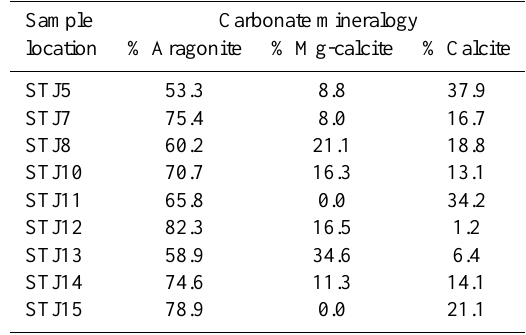
Table 7. NEC:NEP ratios for study sites with nA T vs. nC T r 2 > 0 .